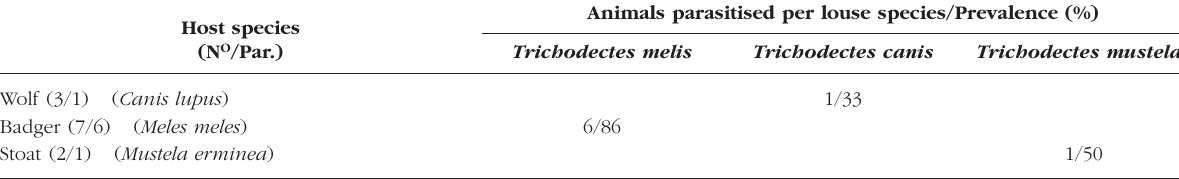
Table III. – Species of lice (order Mallophaga) identified on the host animals.